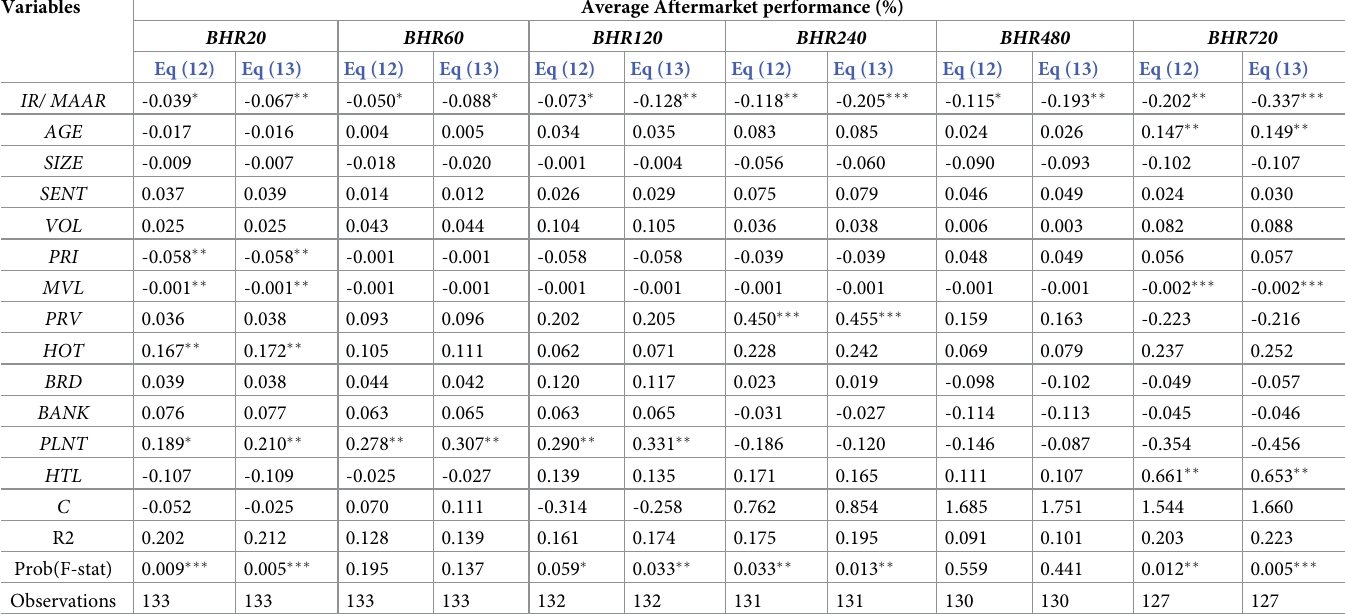
Table 12. Robustness check- multiple regression